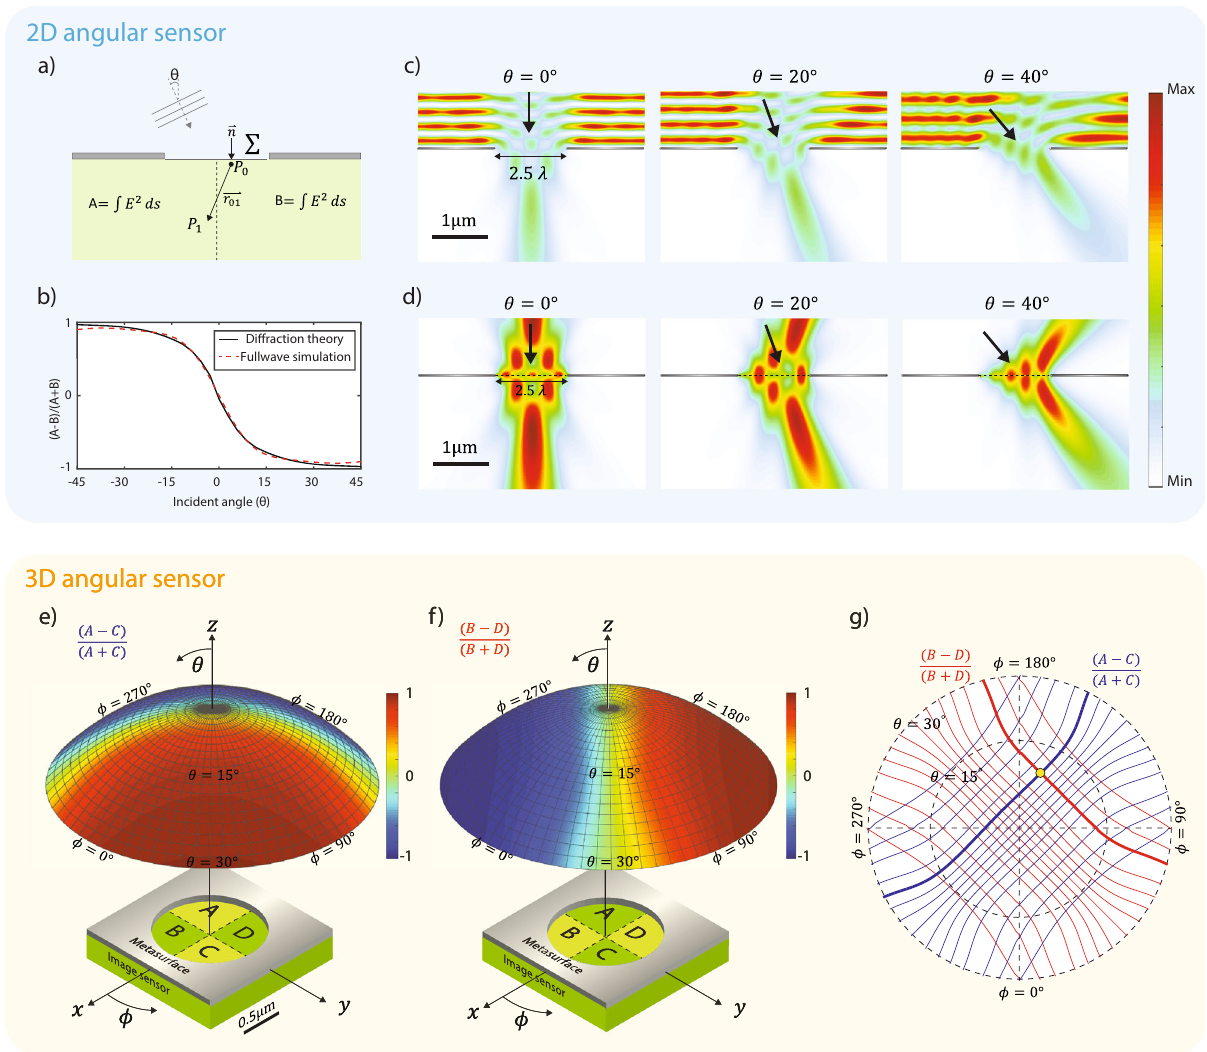
Fig. 2 Schematic of angle sensing in 2D and 3D space. a Schematic of single slit aperture for calculating fi eld energy using Rayleigh – Sommerfeld diffraction theory. b Plot of total energy ratio between two equally divided regions (A and B) for different incident angles. Calculation based on full-wave simulation and Rayleigh – Sommerfeld diffraction theory are in good agreement. c The electric fi eld intensity pro fi le of a plane wave incident on a PEC slab with an open aperture of 2.5 λ width. The intensity pro fi le is a strong function of the incident angle θ . d The scattered fi eld by the open aperture. It is calculated by subtracting the incident fi eld from the total fi eld. The incident fi eld is de fi ned as the fi eld without the open aperture but with a perfect PEC re fl ector. e Schematic of angle sensor with an aperture on four photodetectors labeled by A, B, C, and D. The map of energy ratio ð A (cid:1) C Þ ð A þ C Þ for different incident angles is shown on the hemisphere. Each point on the hemisphere represents one combination of polar angle θ and azimuthal angle ϕ . f The map of energy ratio ð B (cid:1) D Þ ð B þ D Þ . g Contour lines extracted from hemisphere in e and f . A unique incident angle can be determined when two ratios ð A (cid:1) C Þ ð A þ C Þ and ð B (cid:1) D Þ ð B þ D Þ are measured by the four